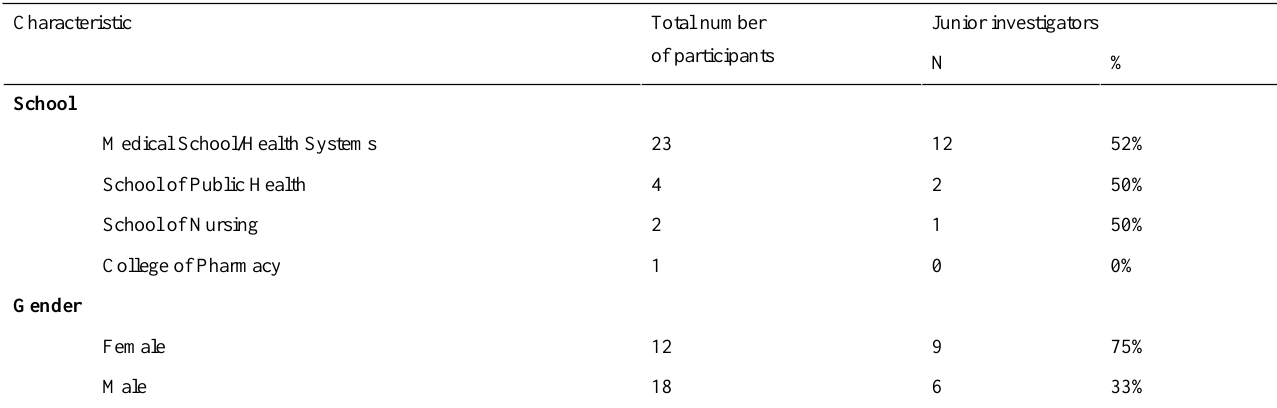
Table 1. Participant characteristics (N =